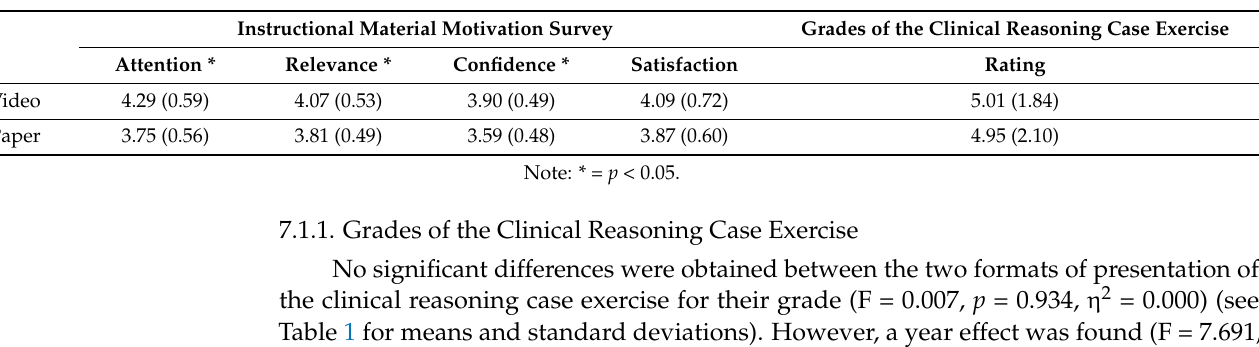
Table 1. Means and standard deviations for each dimension of the IMMS and grades of the clinical reasoning case exercise according to the format (video or paper).